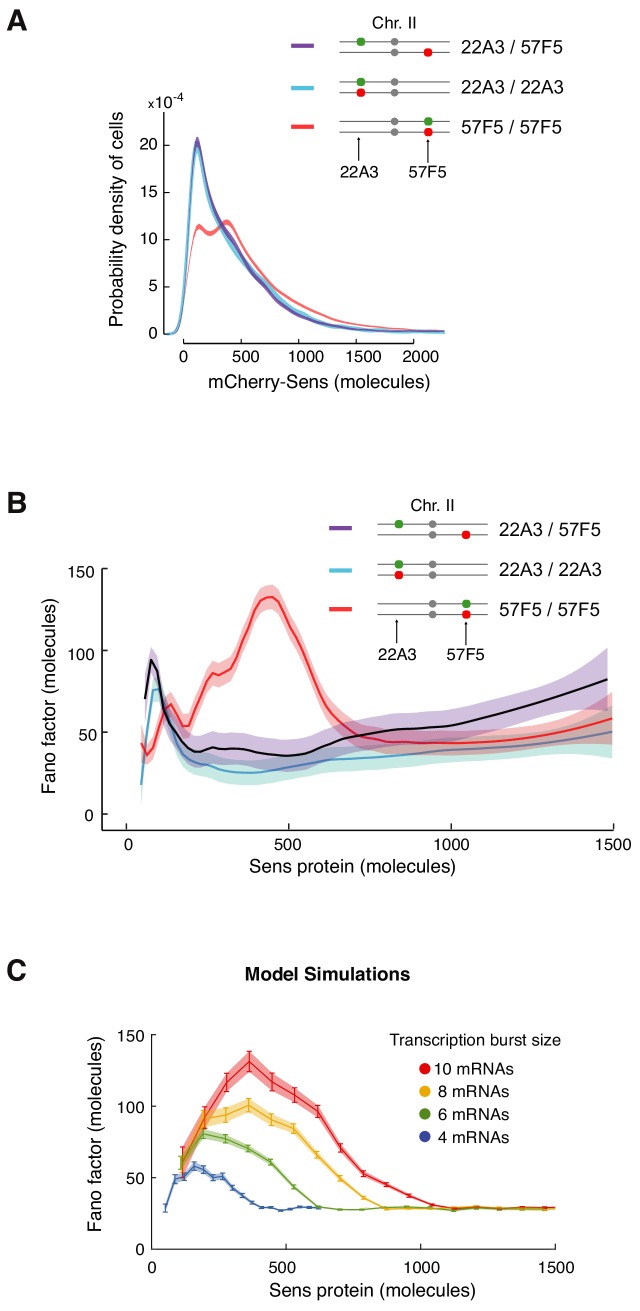
Enhanced protein noise requires trans regulation at 57F5.(A) Frequency distribution of mCherry-Sens protein number in cells. The mCherry-sens allele is located at either 22A3 or 57F5 as indicated. The sfGFP-sens allele is either paired or unpaired with the mCherry-sens allele as indicated. Lines are 95% confidence intervals of moving averages (see also Figure 6—figure supplement 1). (B) The Fano factor of Sens from cells expressing Sens protein either from paired alleles (22A3/22A3 and 57F5/57F5) or unpaired alleles (22A3/57F5). Moving line averages are shown, and shaded regions are 95% confidence intervals. (C) Model simulations in which transcription burst size (defined as Sm/koff) is set to different values as shown. The Fano peak amplitude and position change as burst size varies, but all relax to a constant basal level. These trends are similar to those observed in (B). Error bars and shaded regions are 95% confidence intervals (see also Figure 6—figure supplement 2).